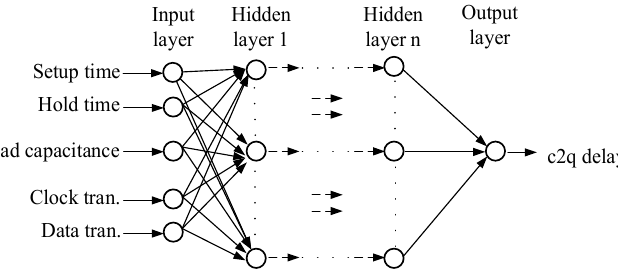
Figure 8. ANN employed for clock-to-q delay prediction.